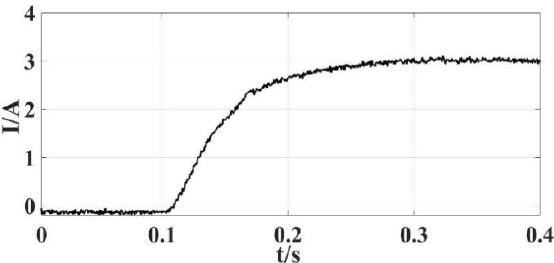
Figure 21. Current rise curve of neutralized-sharing-bridge SPA.